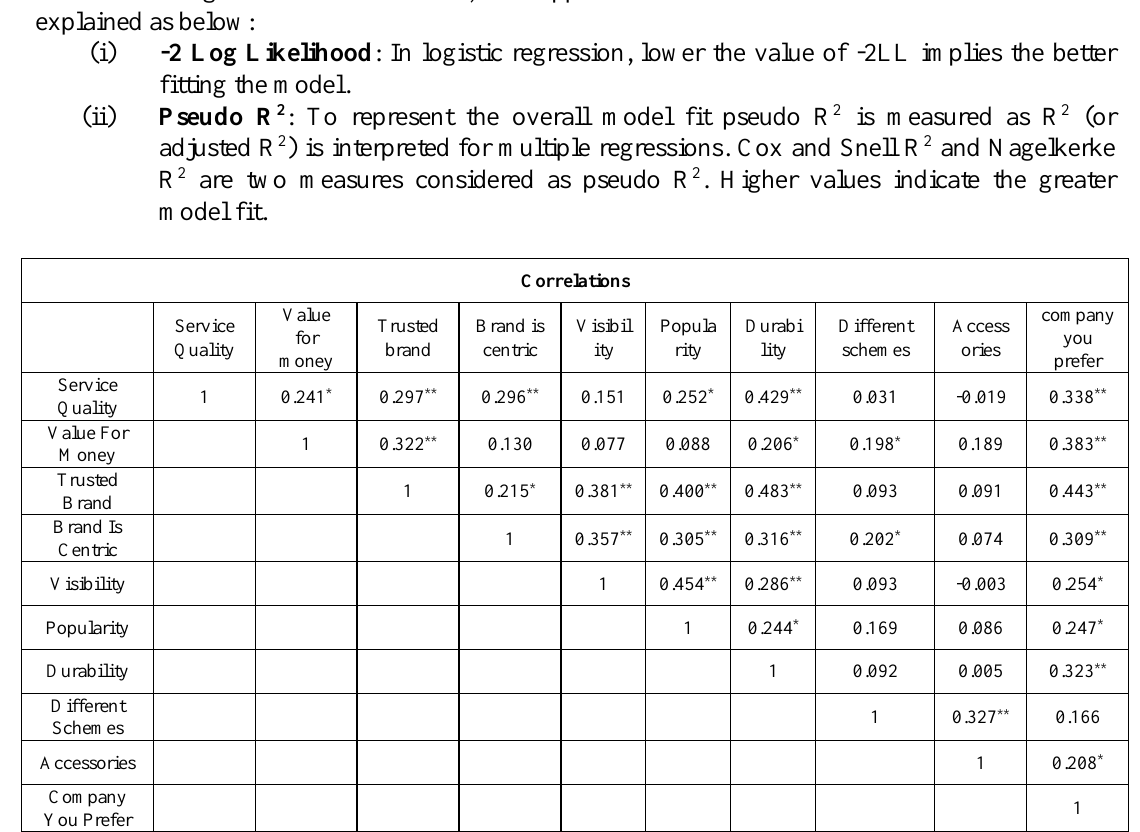
Table 1. Correlations of exogenous variables